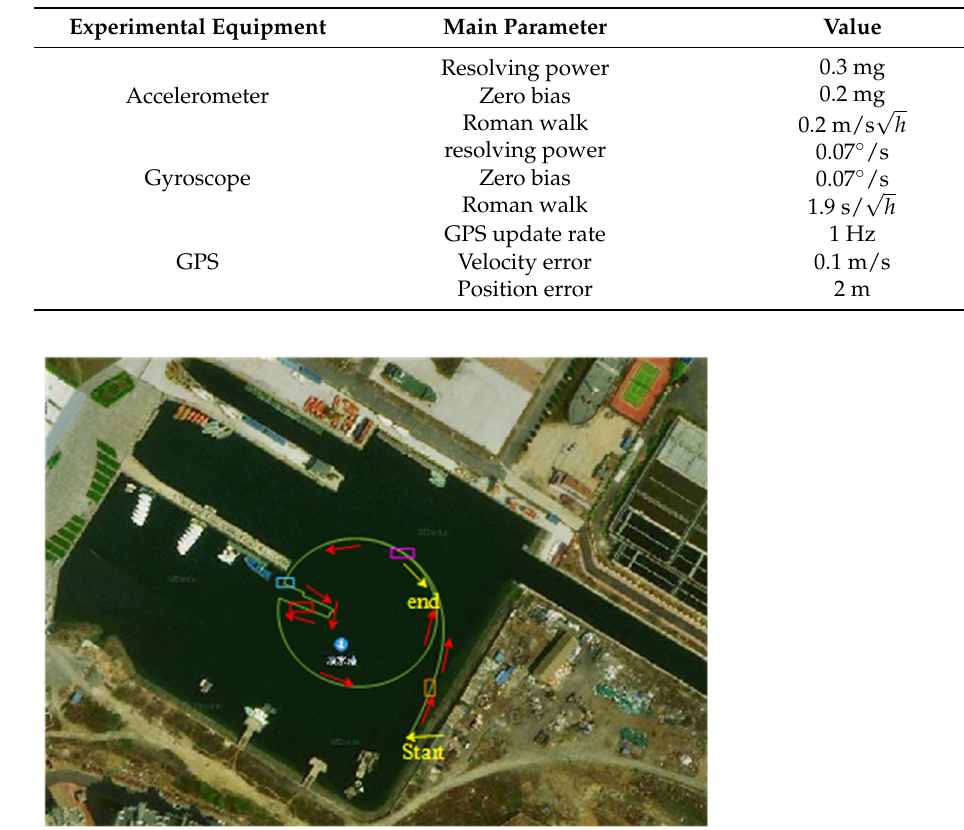
Table 2. Parameters of sensors.